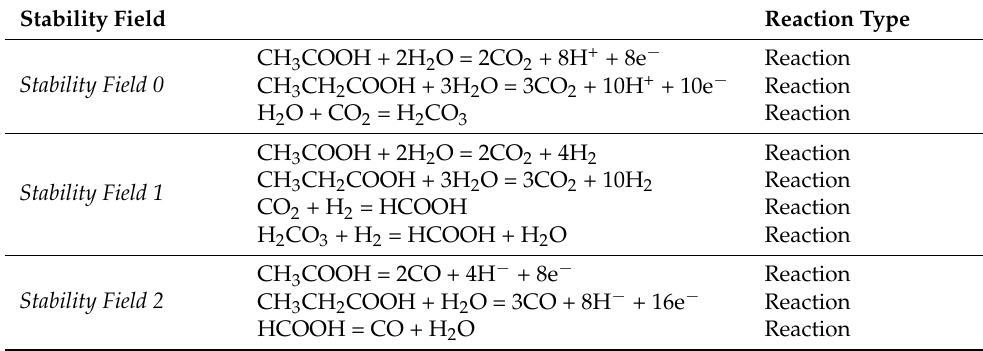
Table 13. Fe 0 degradation of carboxylic acids in the different stability fields. The Eh associated with the gaseous stability transition from CO to CO 2 , given by the reaction: CO + H 2 O = CO 2 + 2H + + 2e −